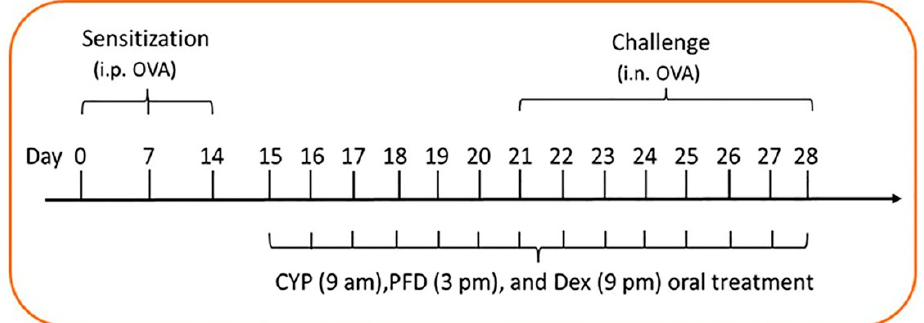
Figure 1. Diagrammatic representation of the different timepoints of the current experiment. i.p.: intraperitoneal, i.n.: intranasal, OVA: ovalbumin, CYP: cypermethrin, PFD: pirfenidone, Dex: